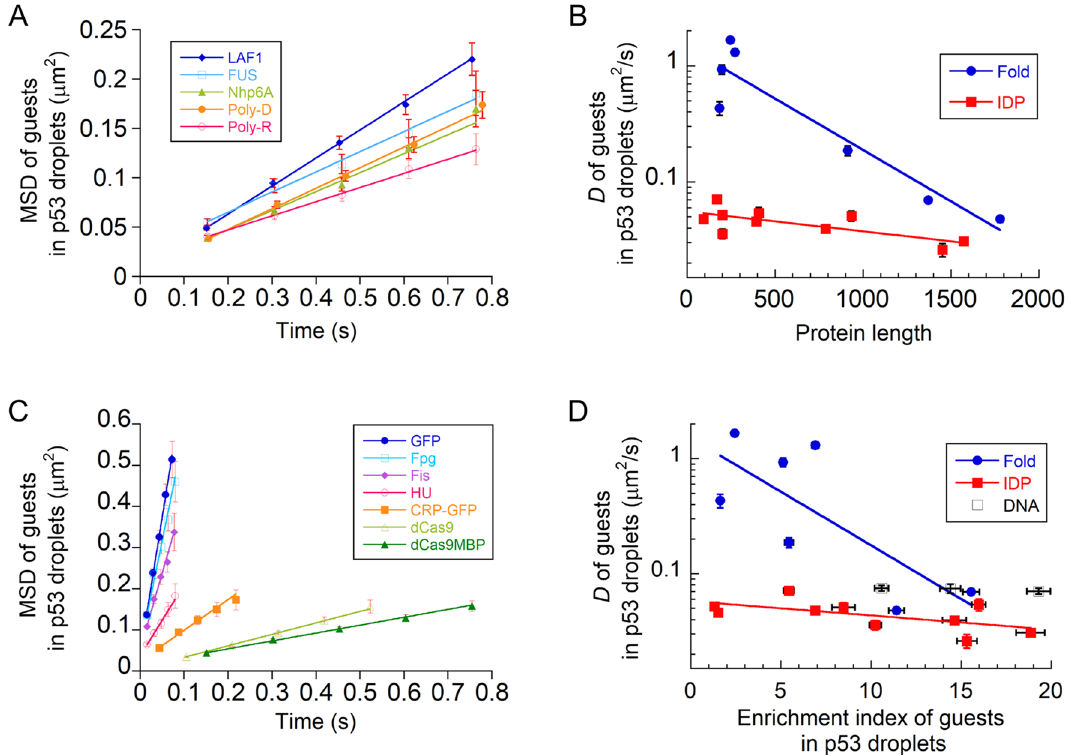
Figure 5. Diffusion of guests in p53 tetramer droplets depend on the structural type and is affected by molecular interaction between host and guests. ( A ) Mean square displacement (MSD) plots of the labeled intrinsically disordered proteins (IDPs) in non-labeled p53 tetramer droplets. ( B ) Protein length dependence of the average D values of guest proteins in non-labeled p53 tetramer droplets. ( C ) MSD plots of the labeled folded proteins and GFP in non-labeled p53 tetramer droplets. ( D ) Enrichment index (EI) dependence of the average D values of guest proteins in non-labeled p53 tetramer droplets. In panels A and C, straight lines show the best-fitted linear functions for the MSD data. In all panels, error bars denote standard errors. In panels B and D, best-fitted lines for the folded proteins (red) and IDPs (blue) are displayed as a guide for